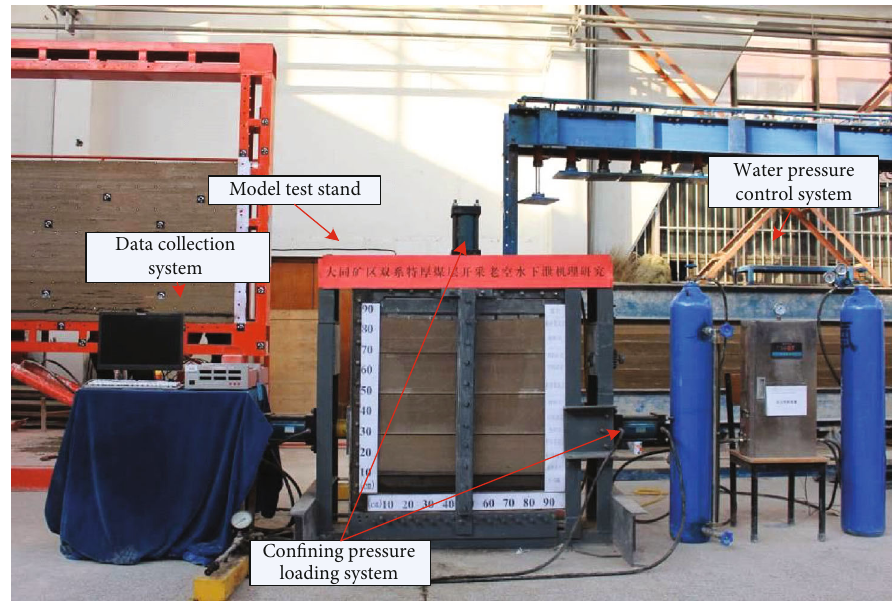
Figure 11: Multi fi eld coupling simulation test system of old goaf and water discharge.